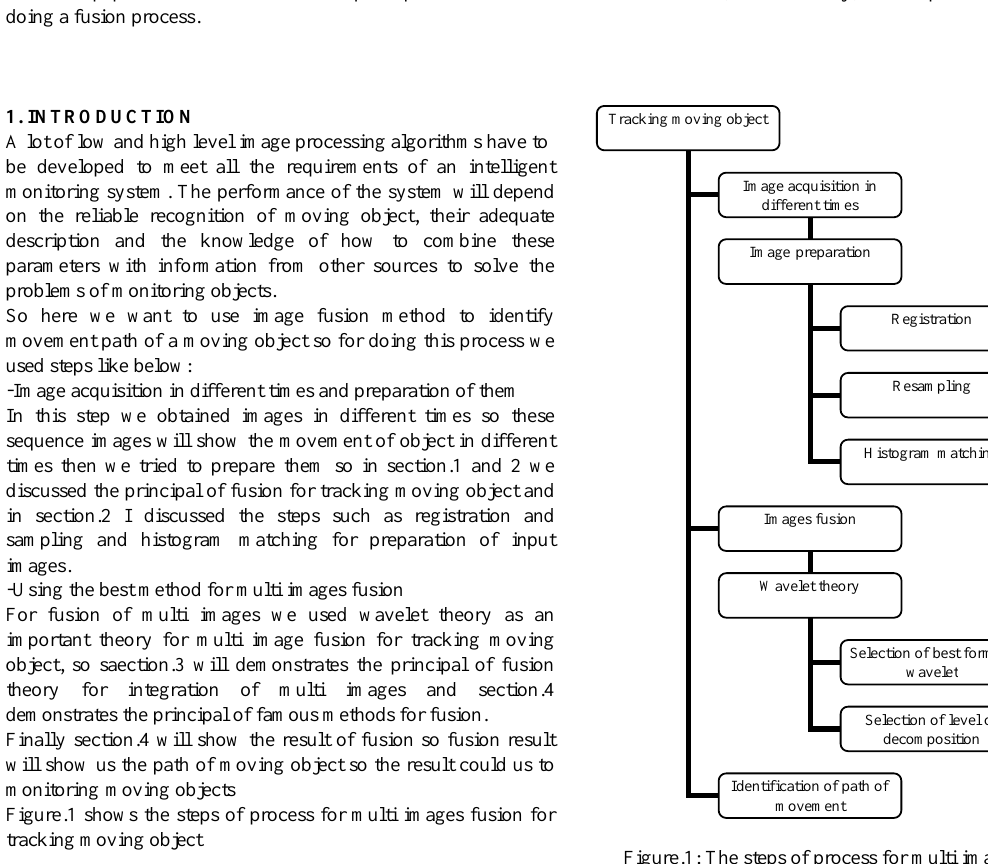
Figure.1: The steps of process for multi images fusion for tracking moving